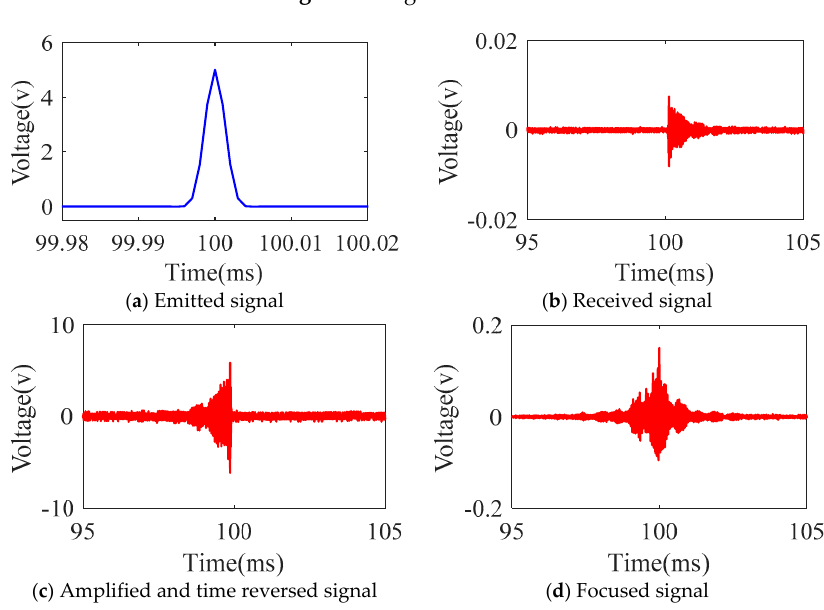
Figure 12. Signal after 35 h.